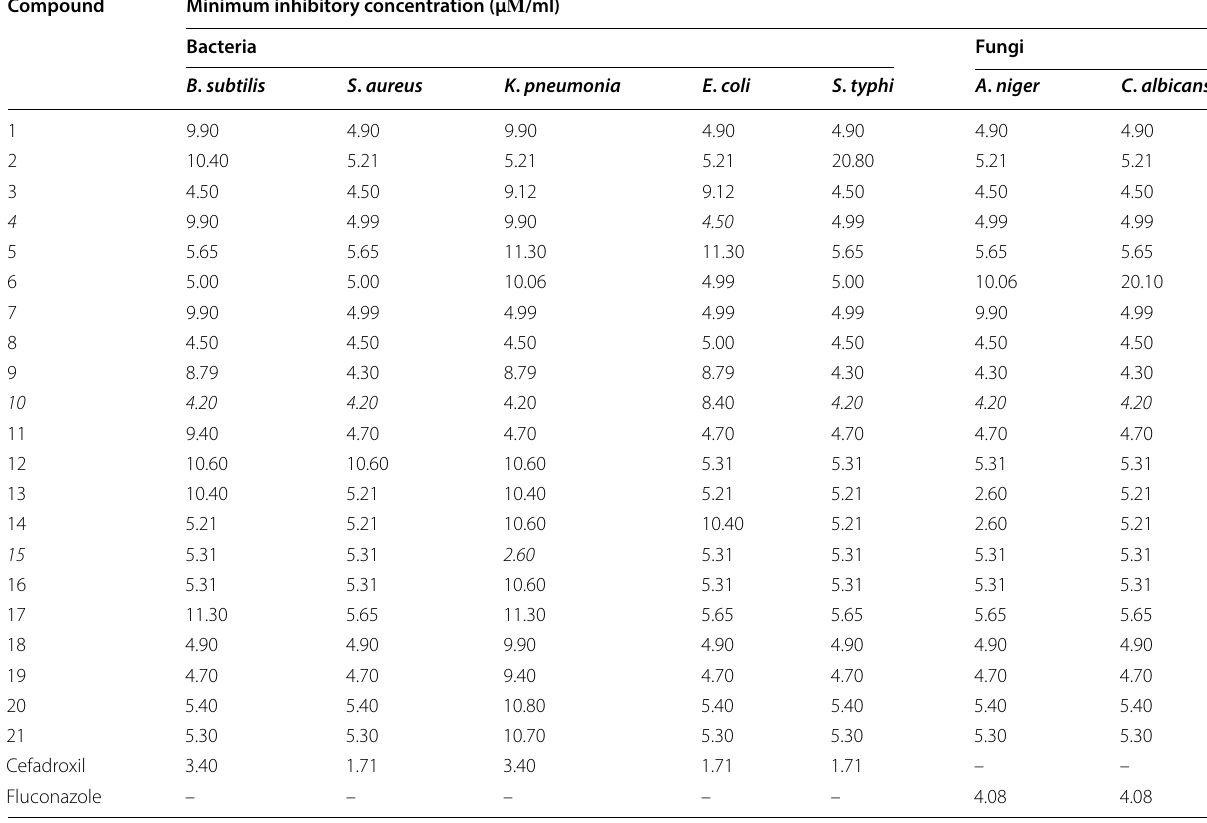
Compound numbers and their significant values are given in italic